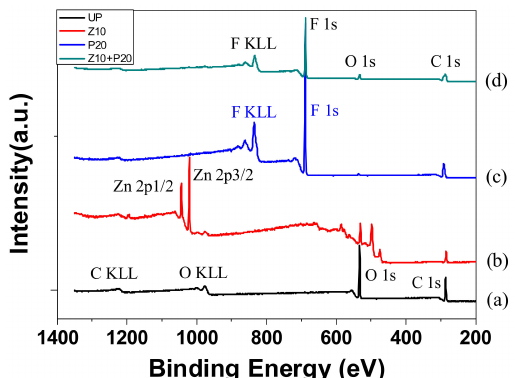
Figure 6. The X-ray photoelectron spectrpmetry (XPS) spectra of ( a ) UP, ( b ) Z10, ( c ) P20, and ( d ) Z10 + P20.